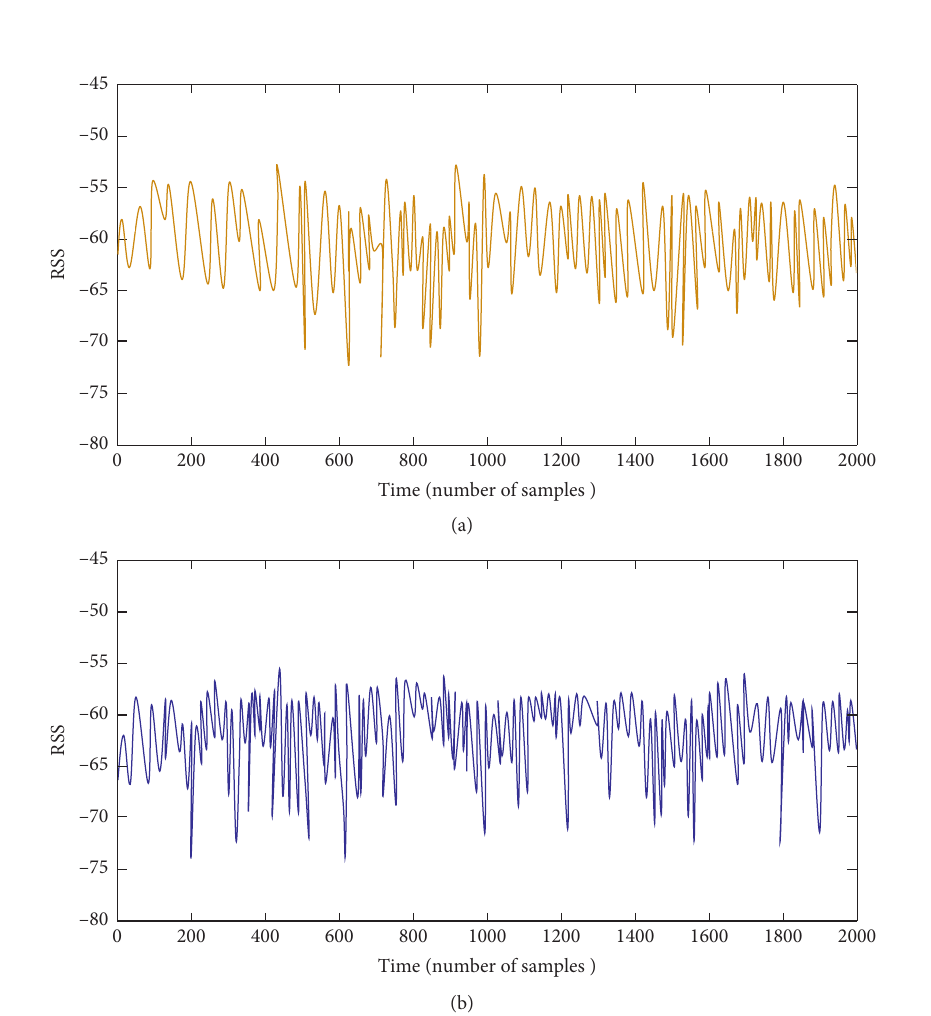
Figure 7: Schematic diagram of RSS value time distribution based on the single